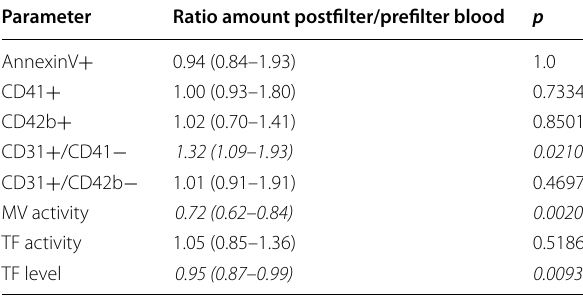
P values refer to the comparison of absolute amounts/minute leaving to the amounts/minute entering the hemofilter via